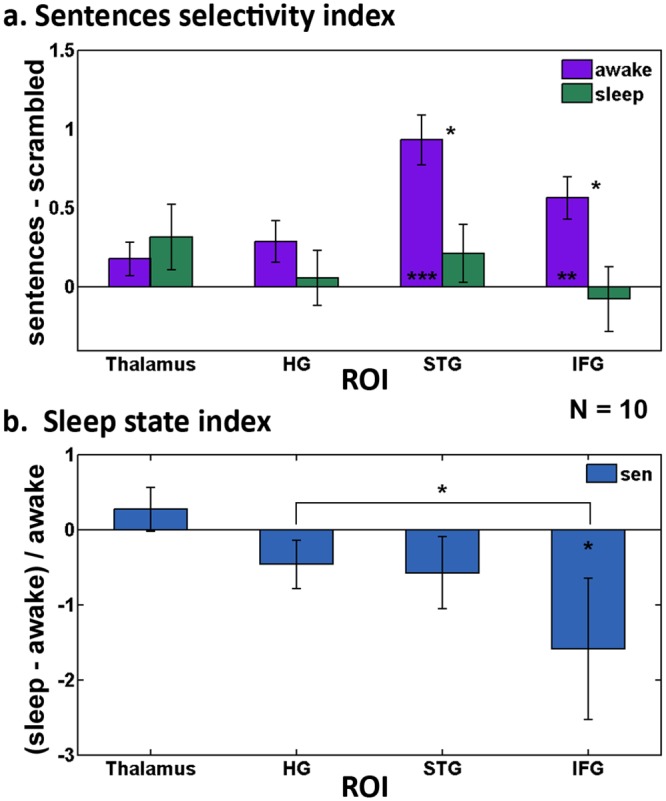
Indices quantifying the effect of sleep on the different ROIs.Beta values were used to calculate the indices (n = 10). (a) Mean index assessing semantic selectivity during wakefulness (purple) and sleep (green), calculated by subtracting betas of scrambled from comprehensible sentences in each of the ROIs. (b) Median index measuring the effect of sleep on the response to comprehensible sentences, calculated by subtracting awake betas from sleep betas and dividing by awake betas for the comprehensible sentences category. Note the graded decrease in the index values moving along the hierarchy of semantic processing ROIs. sen = comprehensible sentences. Statistical specifications are the same as in Fig 4.